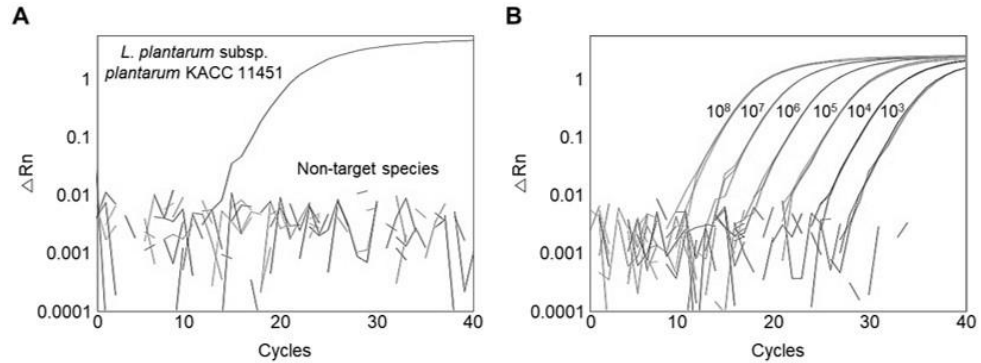
Figure 1. Assessment of primer specificity and sensitivity using qPCR. ( A ) Amplification plot of qPCR; ( B ) amplification plot of serial dilution of genomic DNA of L . plantarum subsp. plantarum KACC 11451.